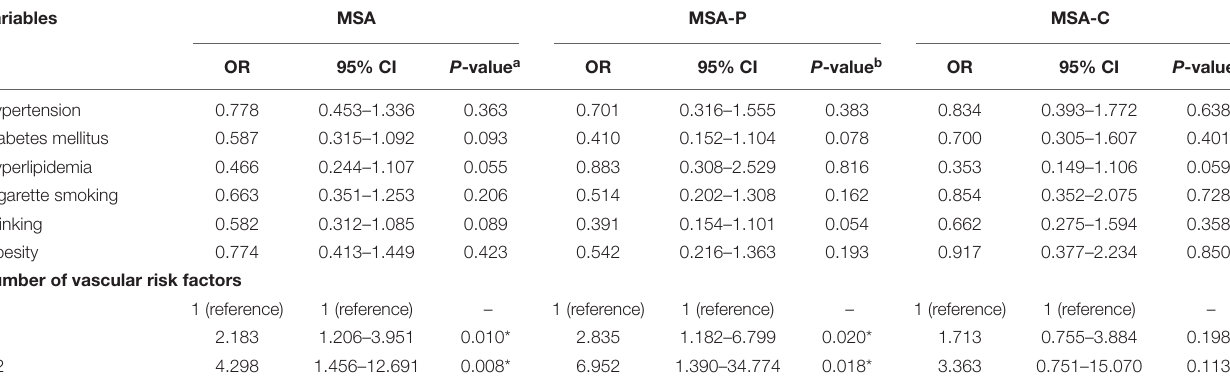
TABLE 3 | The correlation between the vascular risk factors and CI in patients with MSA, MSA-P, and MSA-C in the binary logistic regression